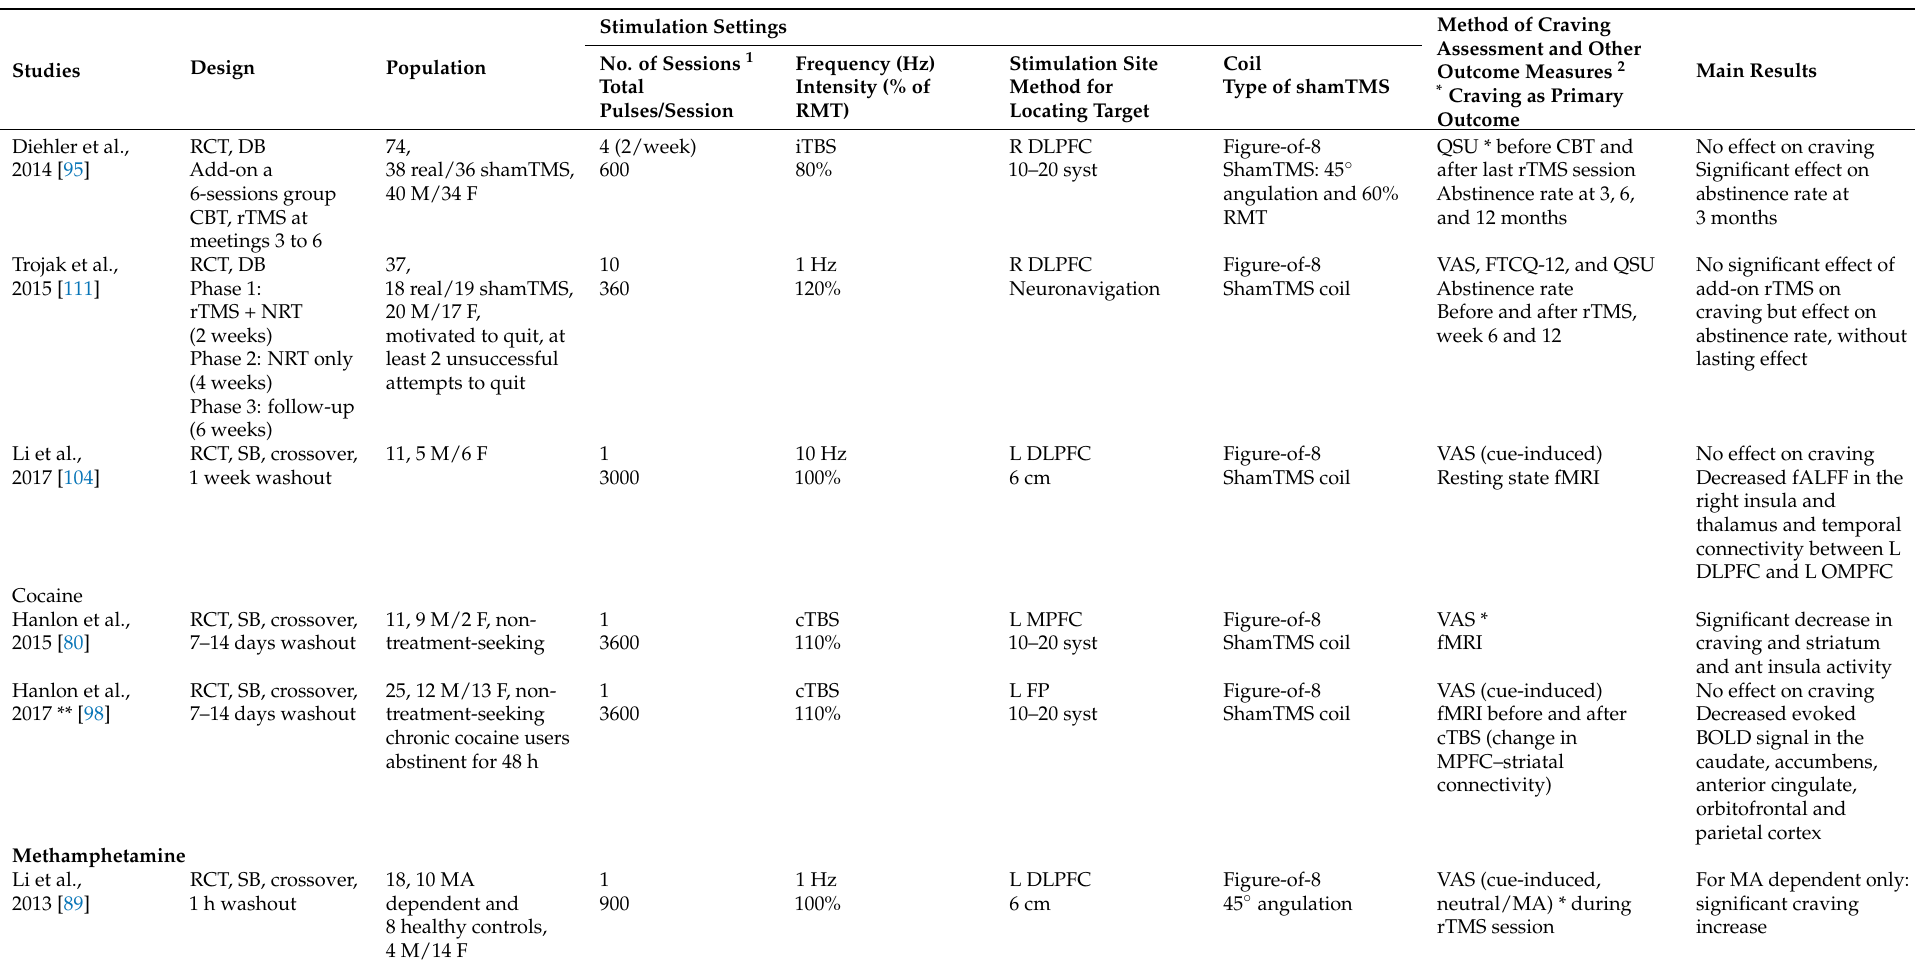
Hanlon et al., L FP Methamphetamine